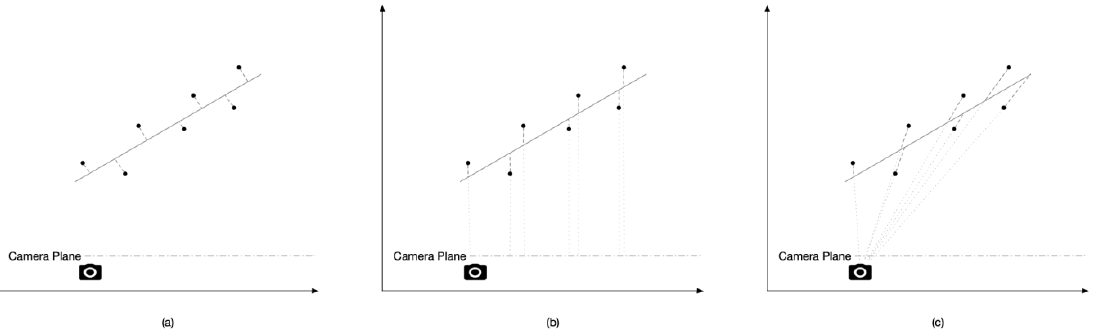
Figure 3. Residuals in different directions: ( a ) perpendicular direction, ( b ) camera’s plane normal direction, ( c ) radial direction .